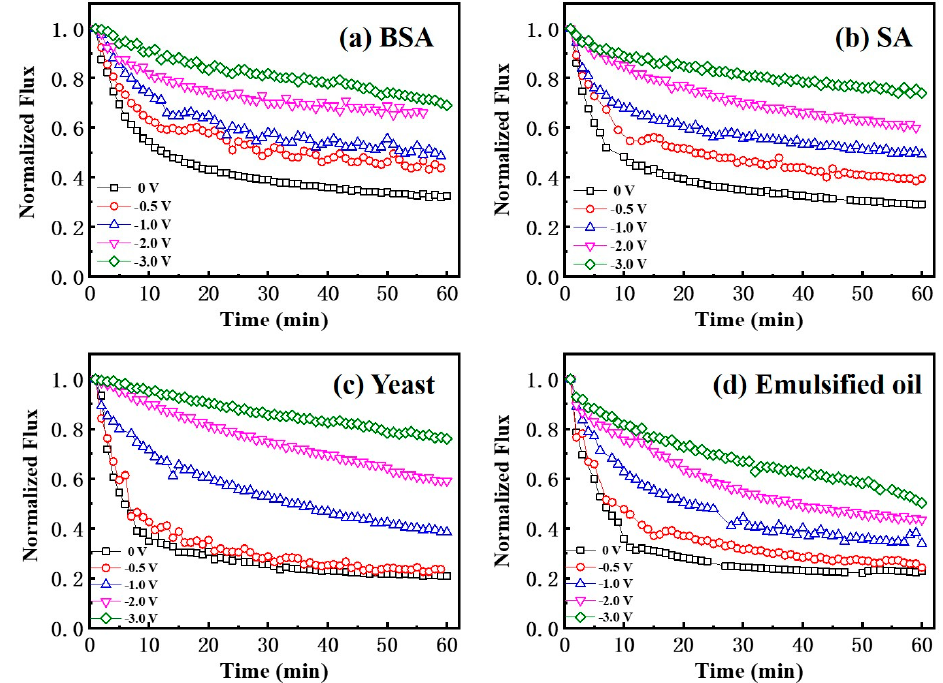
Figure 6. Normalized flux through a Car-PES membrane in comprehensive anti-fouling experiments with different foulant solutions and various negative voltages applied: ( a ) BSA, ( b ) SA, ( c ) yeast and ( d ) emulsified oil (conditions: (BSA) in = 10 mg/L, (SA) in = 10 mg/L, (yeast) in = 10 mg/L, (emulsified oil) in = 10 mg/L, (Na 2 SO 4 ) = 10 mM, (cross-flow velocity) = 6.1 cm/s and (pressure) = 0.1 bar.)